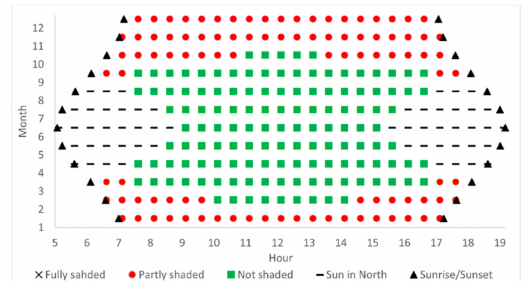
Figure 7. State of shading: north-facing surface, latitude 32 ◦ N, D = 20 m, H = 10 m, L = 40